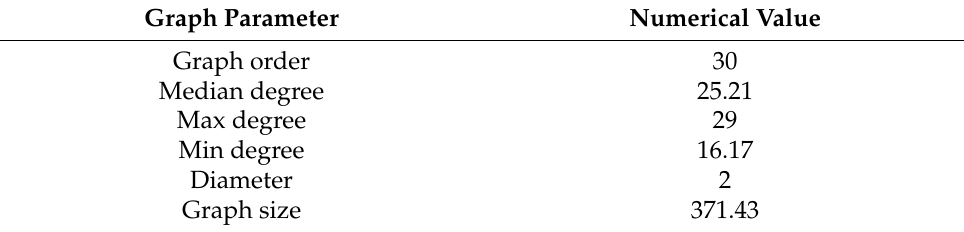
Figure 4. Example of random geometric graphs used in our experiments. Table 1. Graph parameters of 100 RGGs used in our